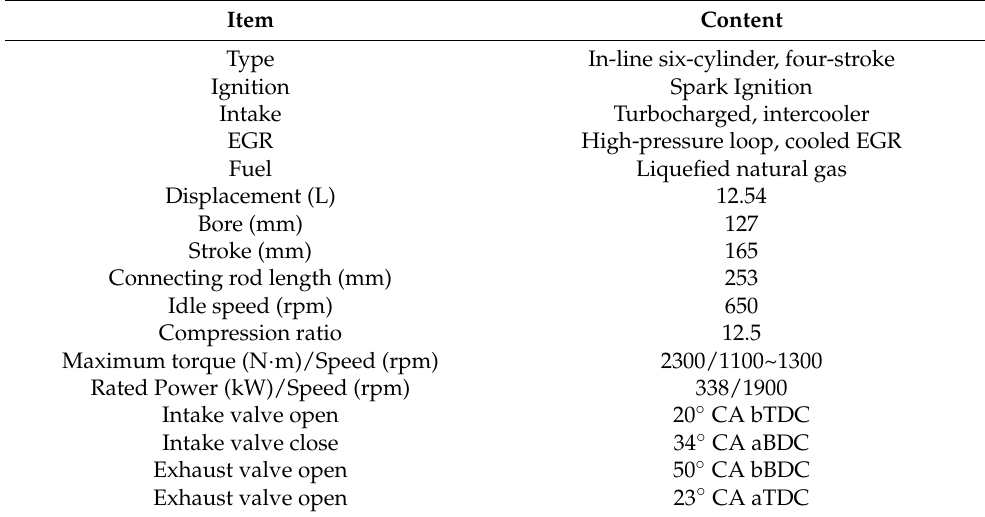
Table 1. The engine specifications.